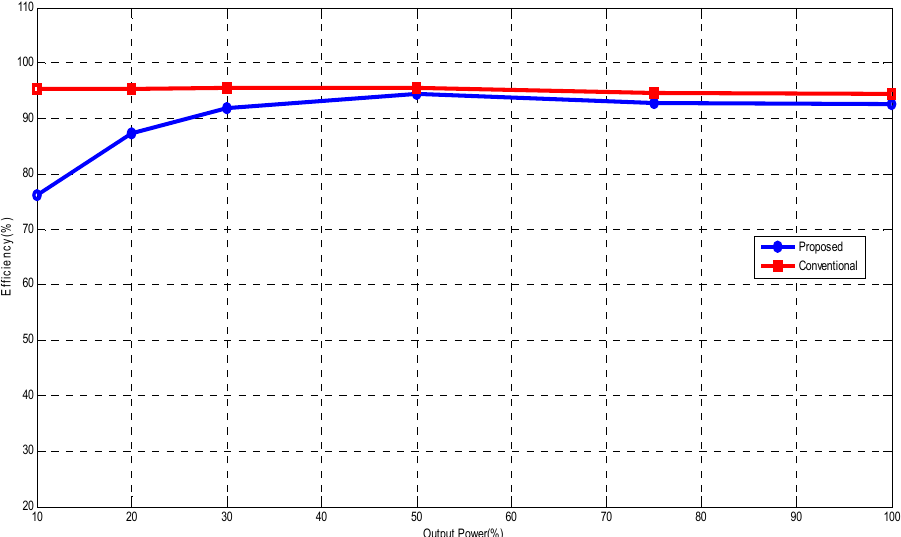
Figure 9. The variation of system efficiency with output power of both conventional and proposed systems.